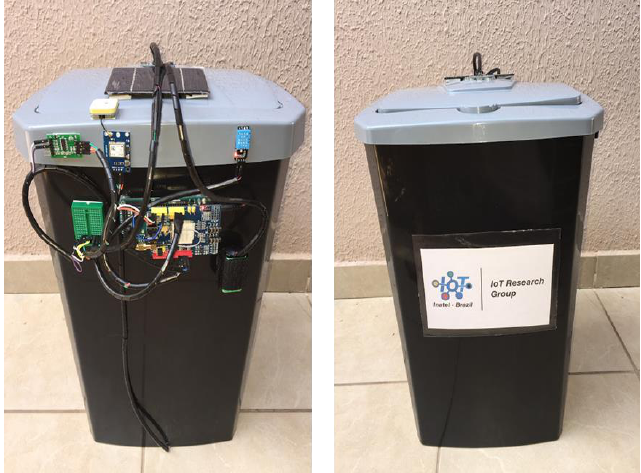
Figure 3. My Waste Bin prototype.